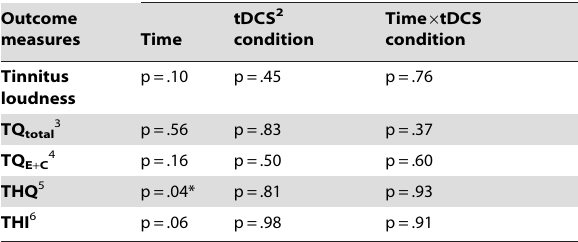
Table 3. Treatment